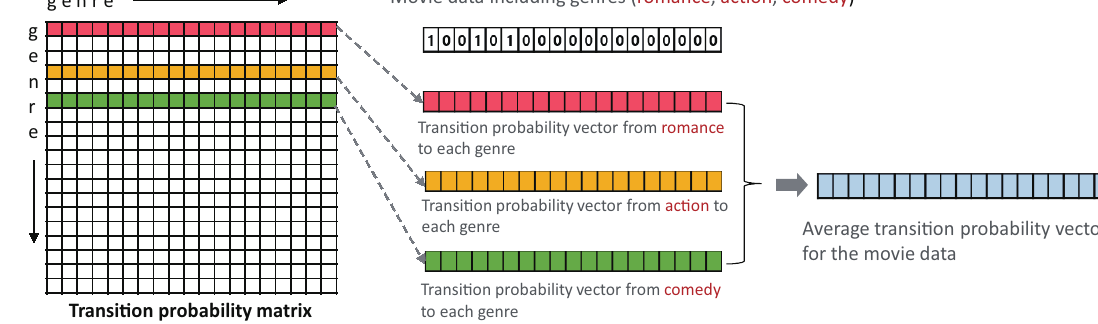
Figure 4. Illustration of example for clustering.